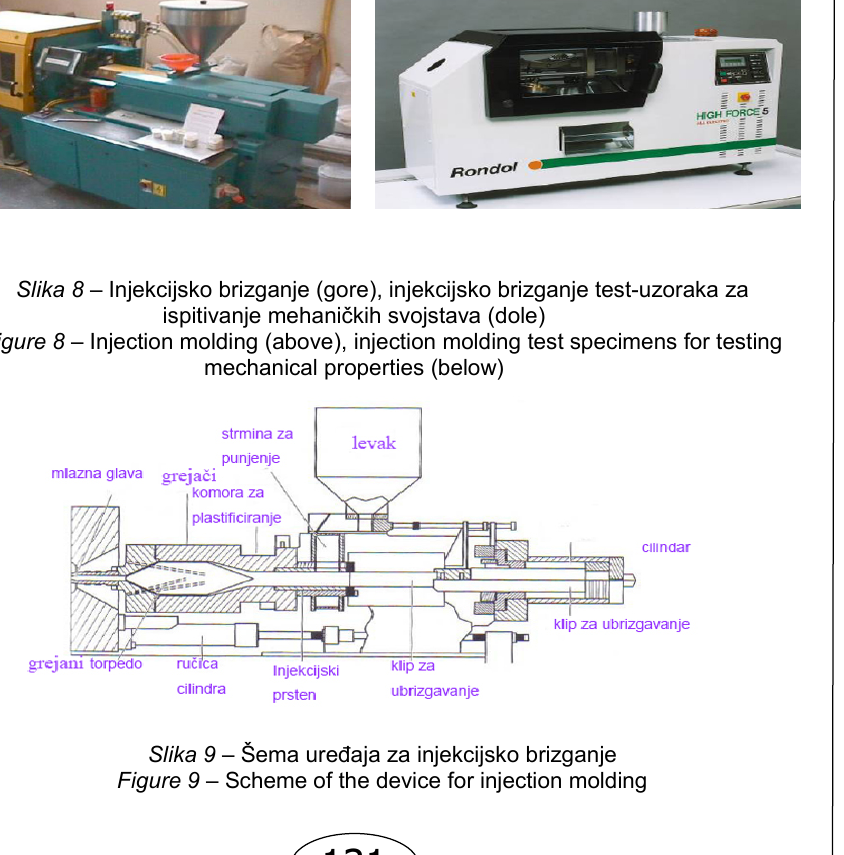
Figure 9 – Scheme of the device for injection